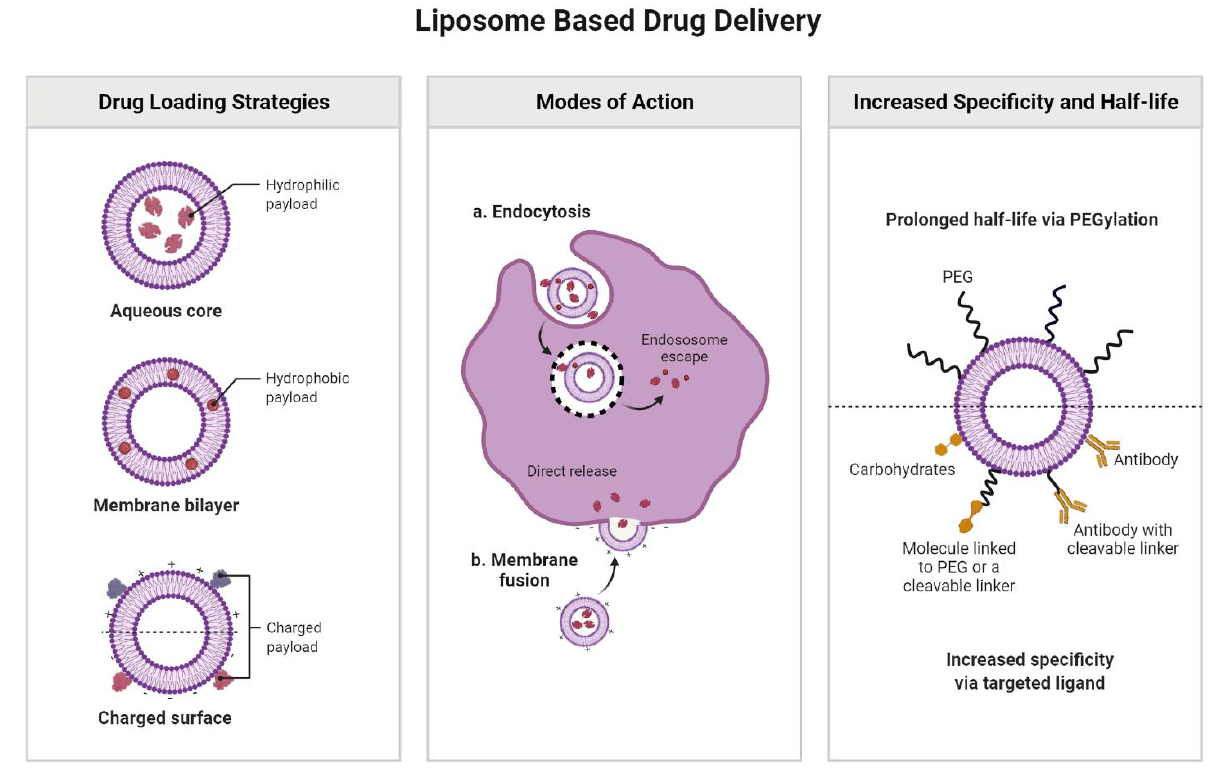
Figure 2. Drug loading